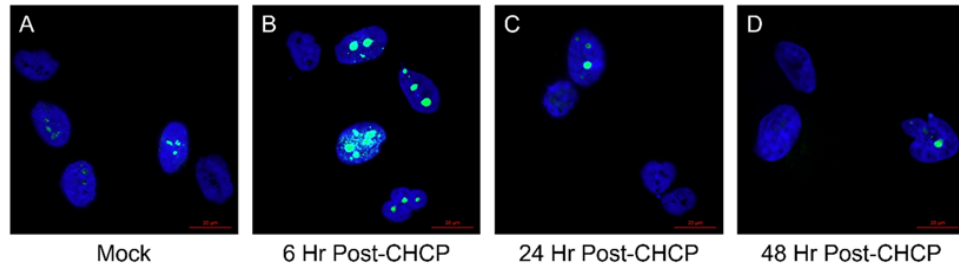
Figure 3. Representative confocal microscopy images showing Ki67 (green) expression in DAPI- stained (blue) ( A ) mock control and CHCP-treated (120 P for 5 min) liposarcoma cells after ( B ) 6, ( C ) 24, and ( D ) 48 h. Most mock control cells expressed Ki67, indicating normal cancer proliferation. CHCP-treated cells showed an initial spike in Ki67 expression after 6 h, followed by a sharp decrease in Ki67 expression after 24 and 48 h.